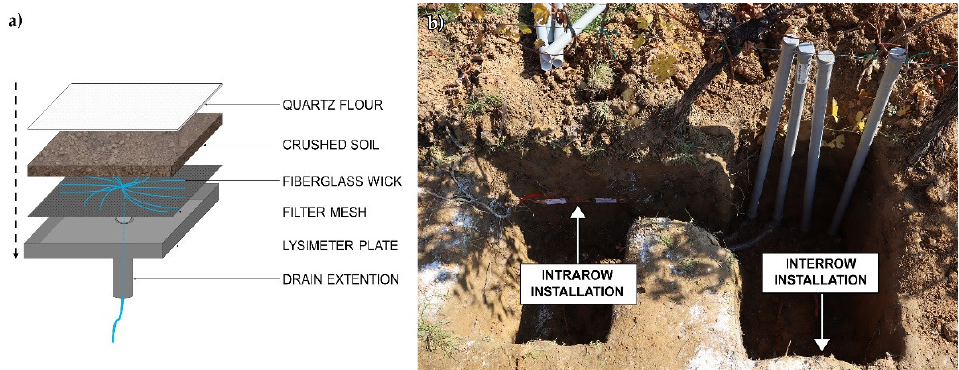
Figure 2. ( a ) Scheme of self-constructed lysimeters, and ( b ) installation in-field points of lysimeters at the SUPREHILL site.